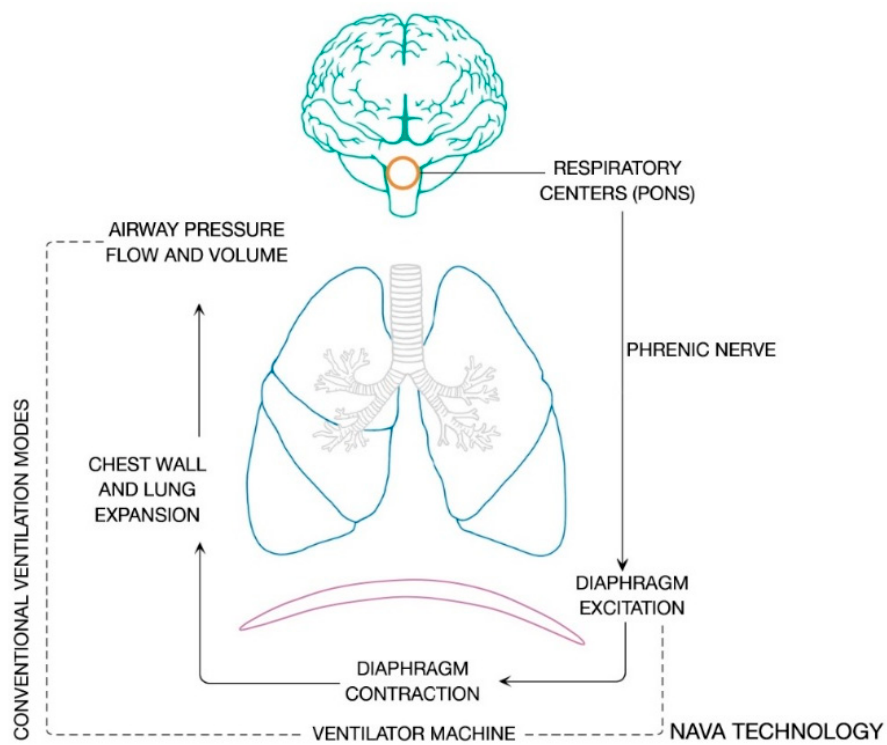
Figure 1. Neuroventilatory coupling process. The figure shows the integration of peripheral chemical and neural afferents at the respiratory centers and the efferent signals which are generated under the neuroventilatory